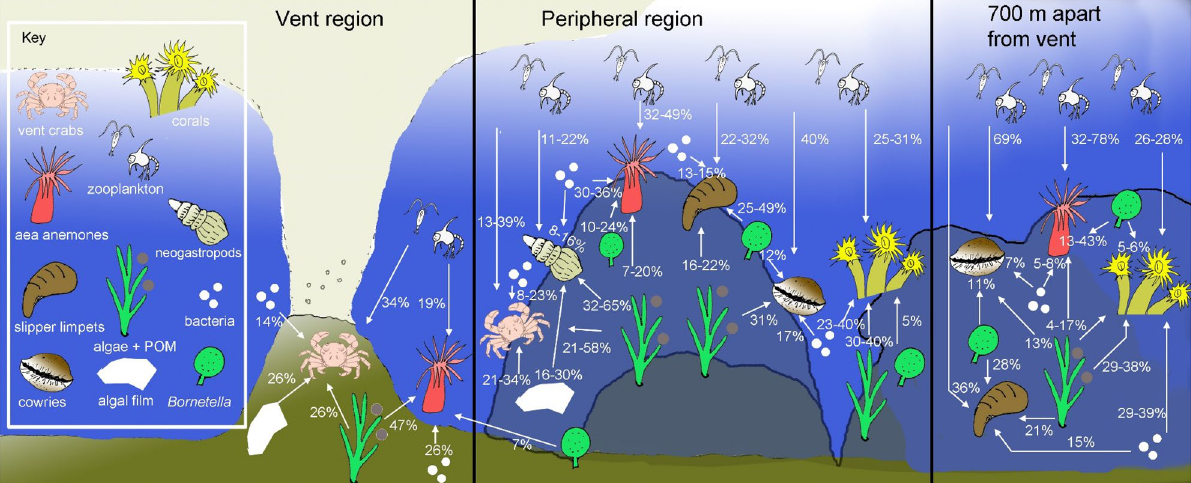
Figure 4. Schematic summary diagram to show the relative contributions (%) of individual food sources to the consumers (see Table 3) near the vent mouths, in the peripheral region, and at 300–700 m apart from the vent